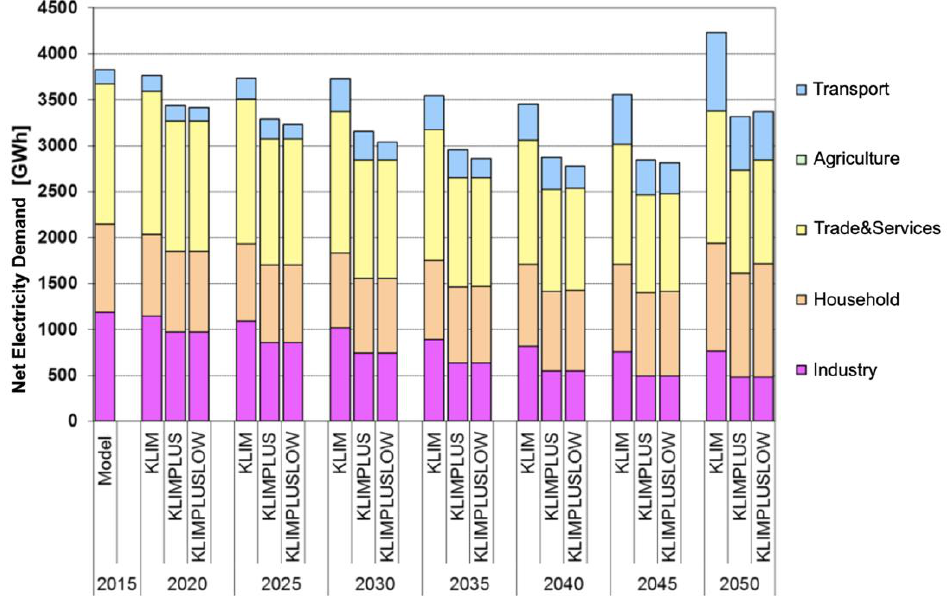
Figure 3. Electricity demand shares by sector in different